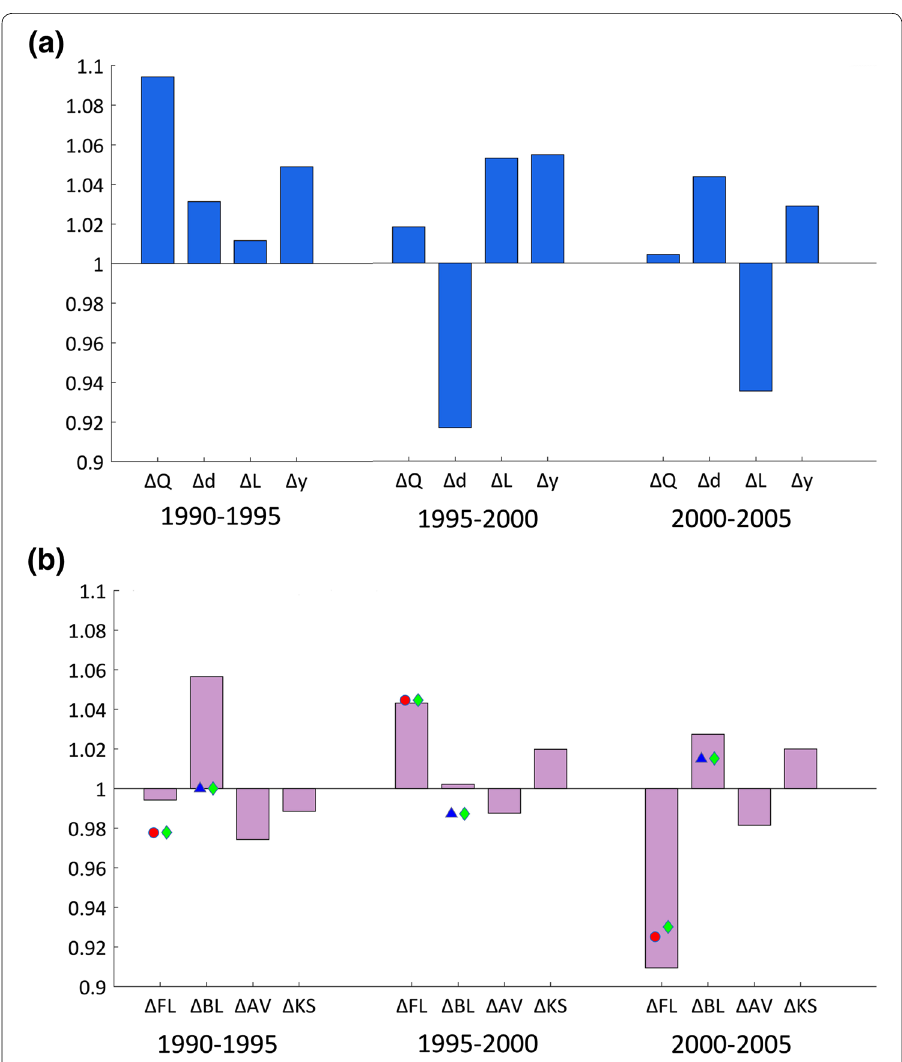
Fig. 3 Effects of the six determinants defined in this study and two linkages of conventional approaches on changing Japanese GHG emissions in three periods (1990–1995, 1995–2000 and 2000–2005). (cid:31) Q means growth ratio of GHG. The other (cid:31) mean the average effect of each determinant on GHG. a Shows (cid:31) Q , (cid:31) d , (cid:31) L (cid:31) y . b Shows (cid:31) FL , (cid:31) BL , (cid:31) AV , (cid:31) KS . b Includes the results of comparison with conventional m 1 m 2 methods. Blue triangles show the effects by method 1: (cid:31) ˆ BL , red circles are by method 2: (cid:31) ˘ FL and green m 3 m diamonds are by method 3: (cid:31) ˆ BL , (cid:31) ˘ FL